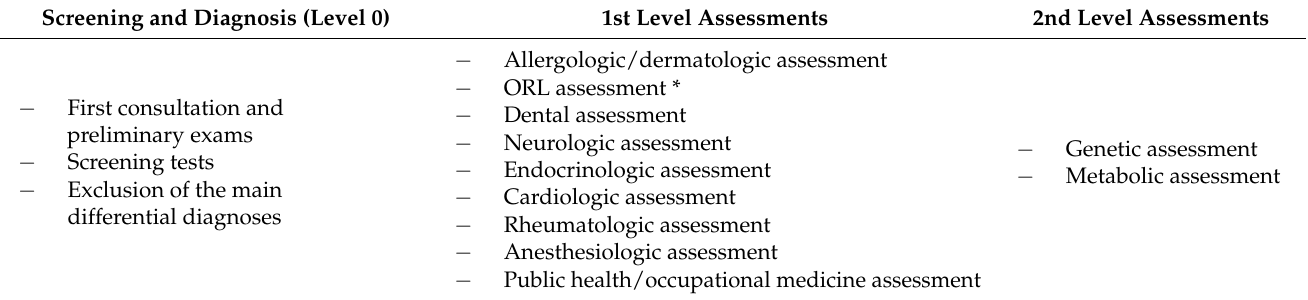
Table 3. Diagnostic and clinical parameters of MCS